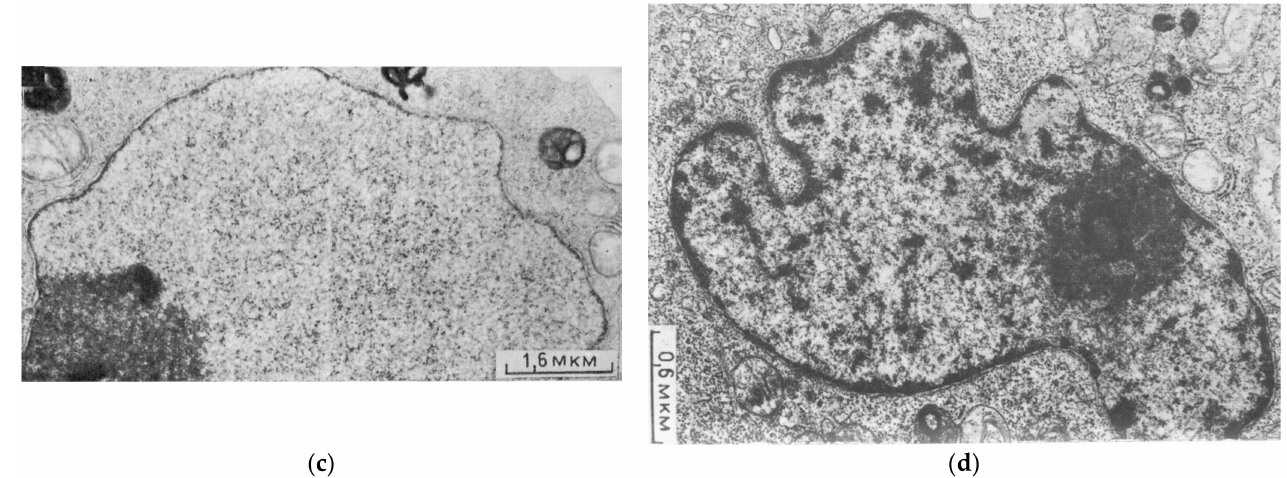
Figure 5. Segregation of the heterochromatin (HR) compartment in SV-40 transformed hamster fibroblast cell line 4/21: ( a ) the undifferentiated growth state; ( b ) after 2 min with bleomycin (01%/HBSS)—the pattern of HR nucleation; ( c ) 20 min bleomycin treatment—no compartmentation after deep chromatin fragmentation; ( d ) 1% DMSO 5-day-induced typical differentiation pattern of HR distribution in cell nuclei of the same cell line; ( a – d ) republished from